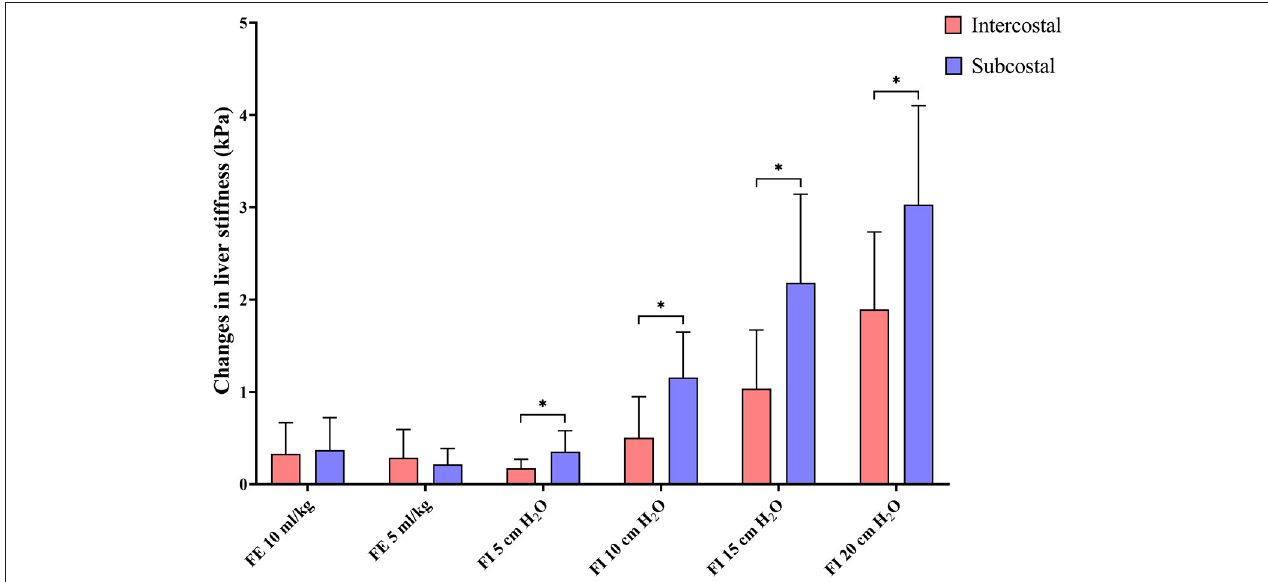
FIGURE 6 | Bar graph representing the changes in liver stiffness. The changes in liver stiffness are calculated by subtracting liver stiffness in end-expiration 0cm H 2 O from liver stiffness in each breathing phase. The bars are grouped by breathing phases, with red and blue representing the intercostal and subcostal approaches, respectively. Changes in liver stiffness are significantly higher in the subcostal approach than in the intercostal approach in all forced-inspiratory phases. * p < 0.05. FE, forced-expiration; FI,